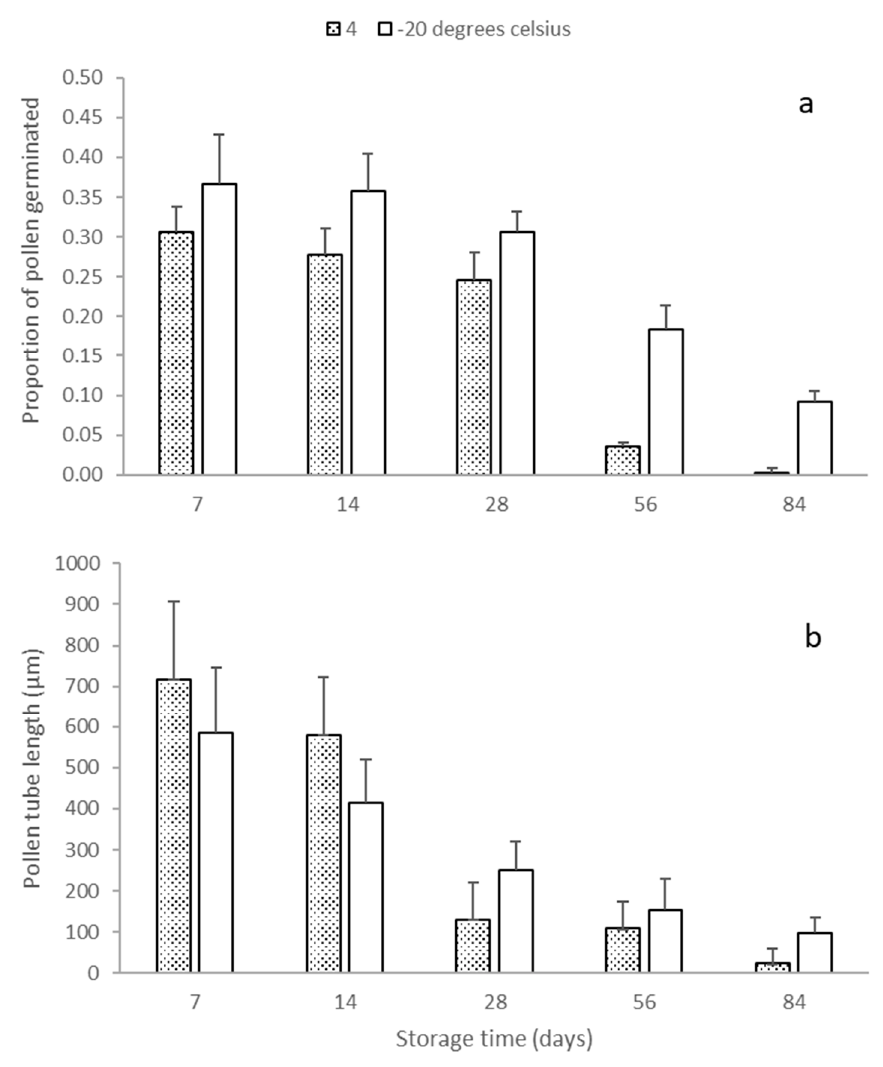
Figure 3. The proportion of pollen grains germinated ( a ) and the tube length ( b ) of Gac pollen following storage at 4 °C and − 20 °C over time. Values are means ( n = 5, ±SD).